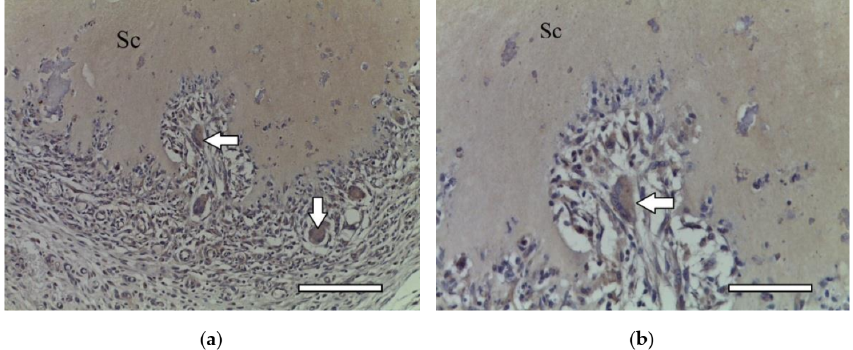
Figure 11. 1st group (dECM only), 2 weeks. Collagen type II in the cytoplasm of multinucleated cells of foreign body resorption (arrows) in the connective tissue capsule. Diffuse background—scaffold material (Sc). Staining for type II collagen (asterisk). ( a ) objective lens × 20, scale bar—100 µ m; ( b ) objective lens × 40, scale bar—50 µ m.